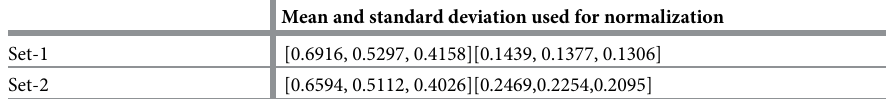
Table 4. Mean and standard